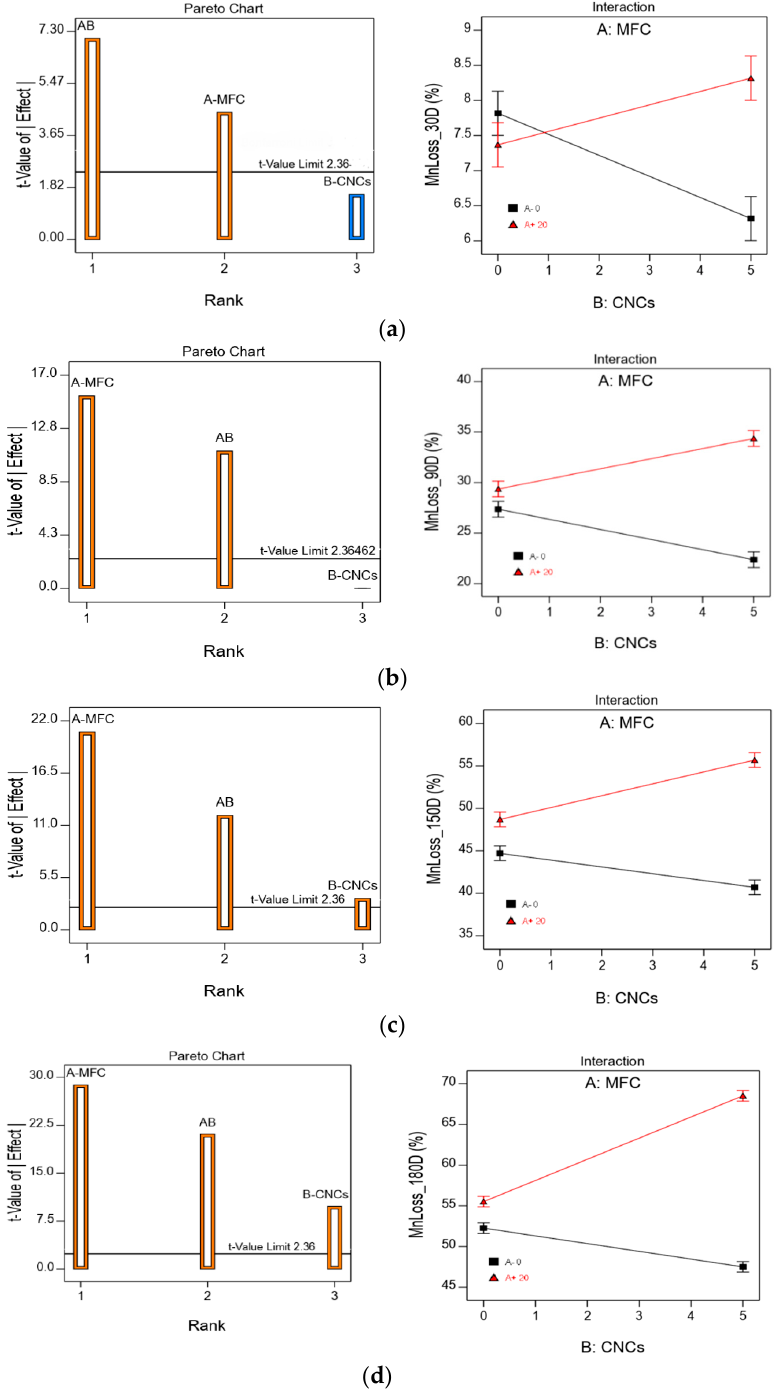
Figure 10. Pareto and interaction graphs for HBC Mn loss for ( a ) 30D; ( b ) 90D; ( c ) 150D; and ( d ) 180 D incubation days. Figure 11 shows the response surfaces and contour graphs for Mn loss at different composting times. The response surface graphs show that the characteristic twist due to the MFC–CNC interaction is present, whereas, in the case of the contour graphs, it can be seen how the contour curves present curvature. In the case of the 30D incubation days, the inter- action is so strong that the contour lines resemble a hyperbolic plot. Likewise, the areas of greatest (red) and least (blue) biodegradation can be distinguished. It can also be observed that the effect of the incorporation of the CNCs in the HBCs is greater during the first 90 days of composting, while, at extended times (greater than 90 days), its effect decreases without MFC; in the presence of MFC, it does not depend on the composting time, i.e., it is almost constant. For example, after 90 days of composting, the effect of incorporating 5% CNCs in- creases the Mn loss by 20%, with MFC, and decreases it by 20% in the absence of MFC. At 180 days of composting, the increase is 24% and the decrease is of the order of 10% with and without MFC in the composite material. ( a ) ( b )